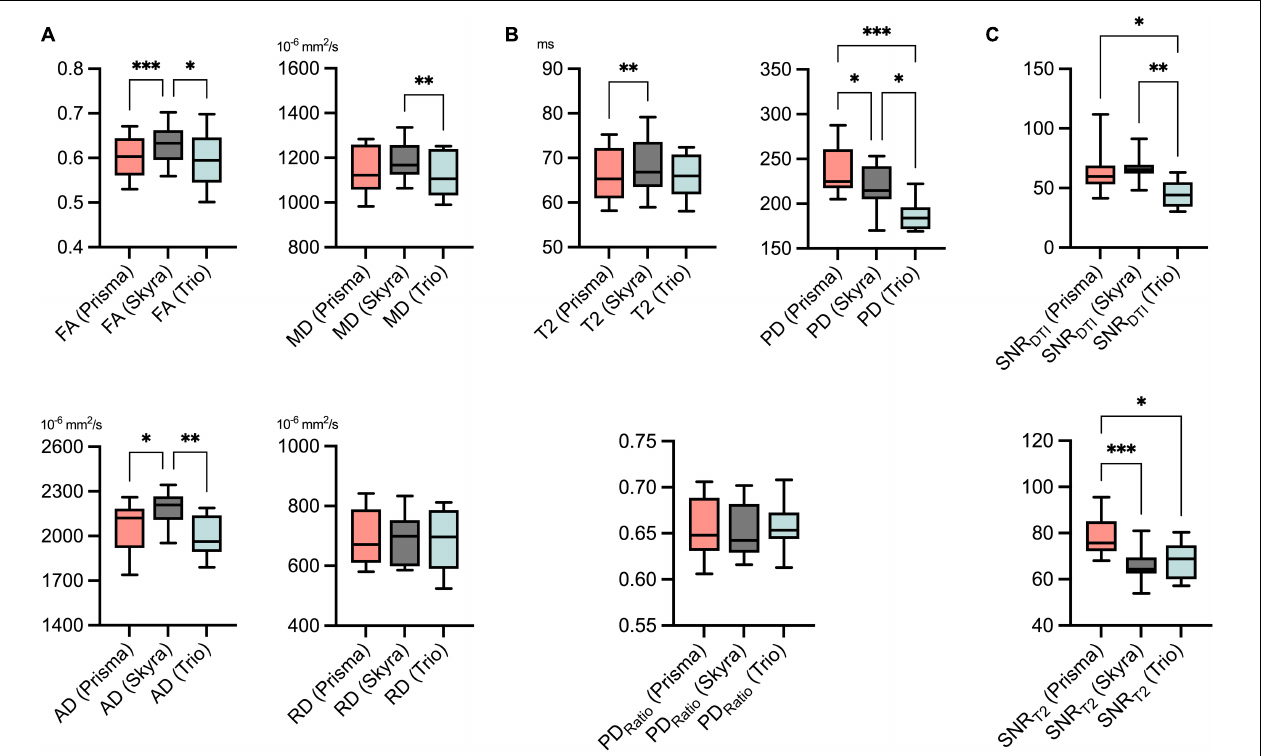
FIGURE 3 | Descriptive statistics for all DTI (A) and T2 relaxometry (B) parameters, SNR (C) values and all three scans, respectively. SNR was assessed separately for diffusion tensor imaging (SNR DTI ) and the T2-relaxometry sequence (SNR T 2 ). Values are illustrated as boxplots to visualize measurement distribution. FA, fractional anisotropy; MD, mean diffusivity; AD, axial diffusivity; RD, radial diffusivity; T2, transverse relaxation time; PD, proton spin density [proportional to proton density per voxel]; SNR, signal-to-noise ratio. Statistical significance is indicated on a level of * p ≤ 0.05, ** p ≤ 0.01, and *** p ≤